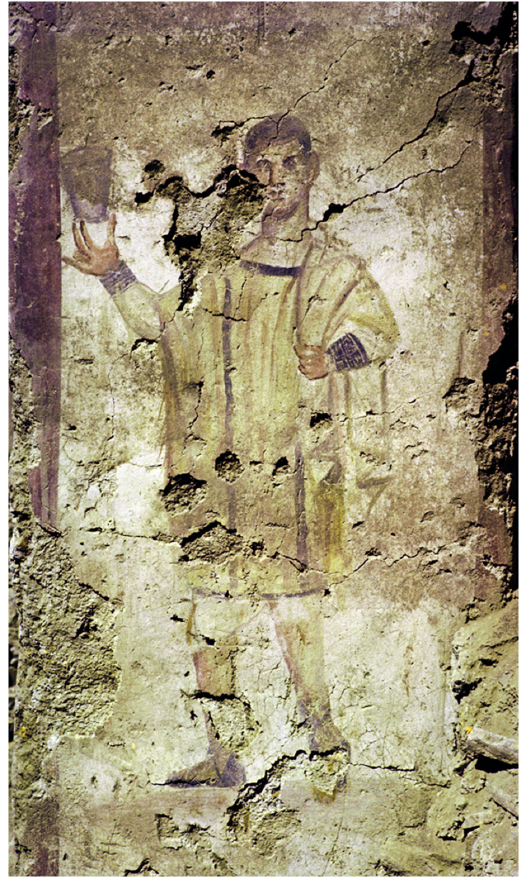
Figure 5. Wall painting depicting a servant with a glass beaker and a towel, 4th century CE. Ephesos, Odeion Terrace House. Efes Müzesi Selçuk. Photo: OeAW-OeAI/Norbert Zimmermann.